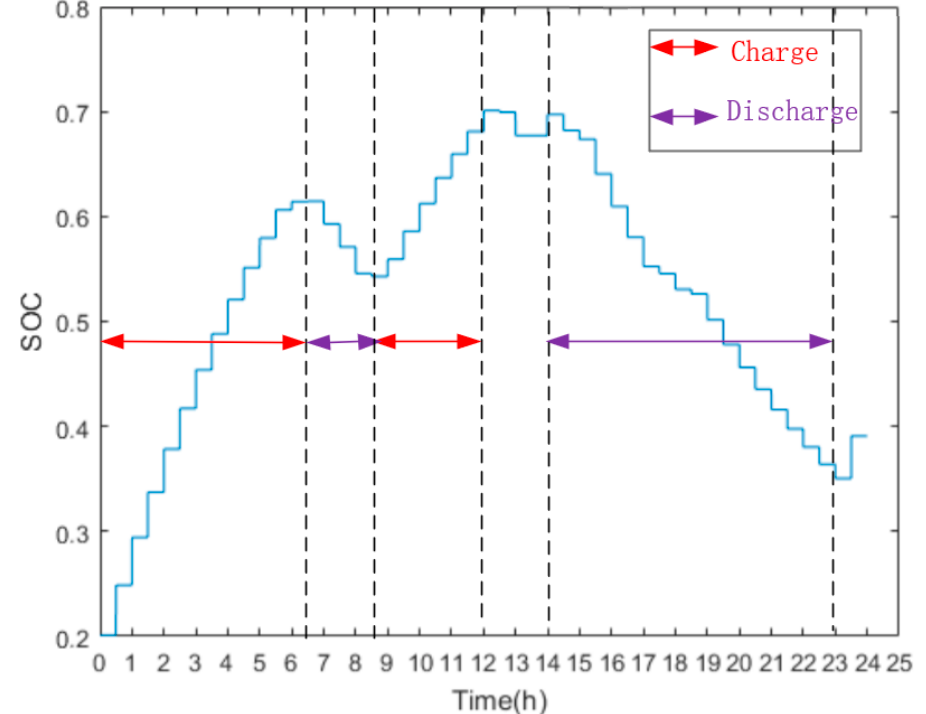
Figure 5. State of the energy storage system.